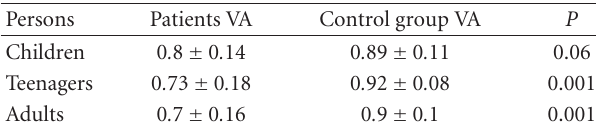
Table 1: Visual acuity in children, teenagers, and adults with Graves’